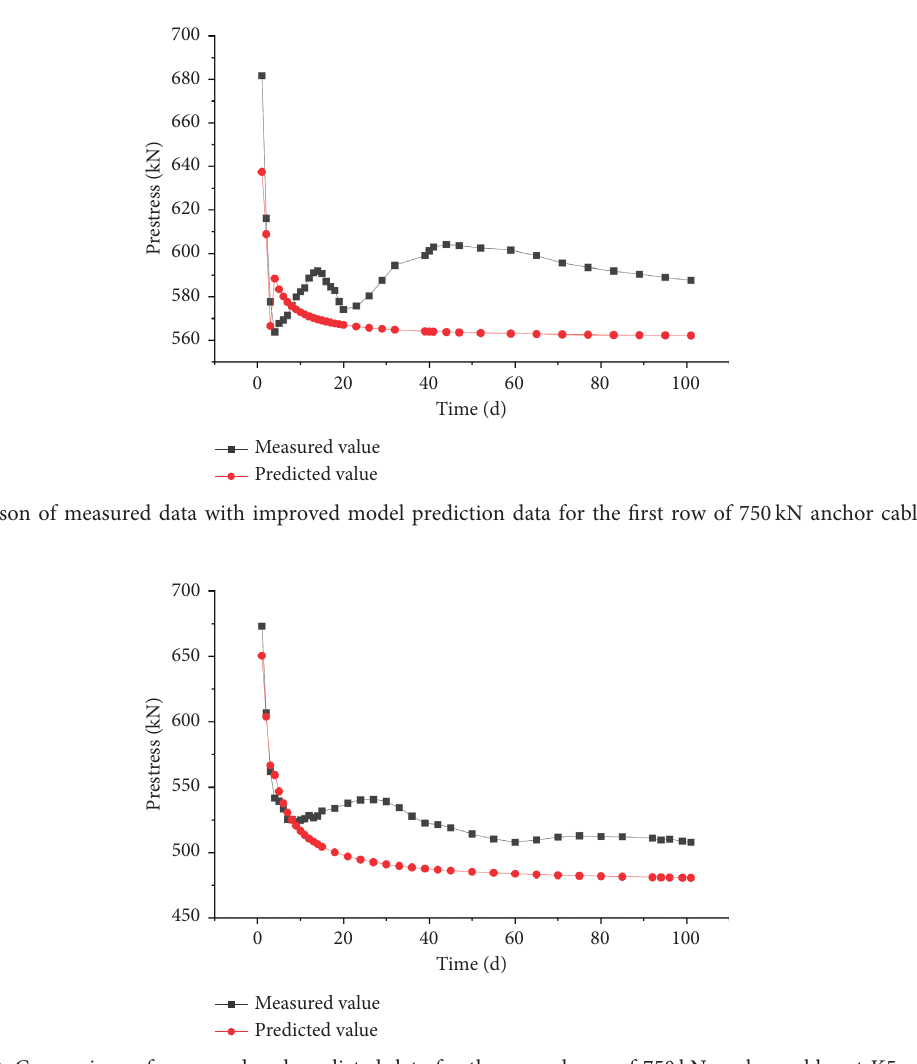
Figure 9: Comparison of measured and predicted data for the second row of 750kN anchor cables at K5